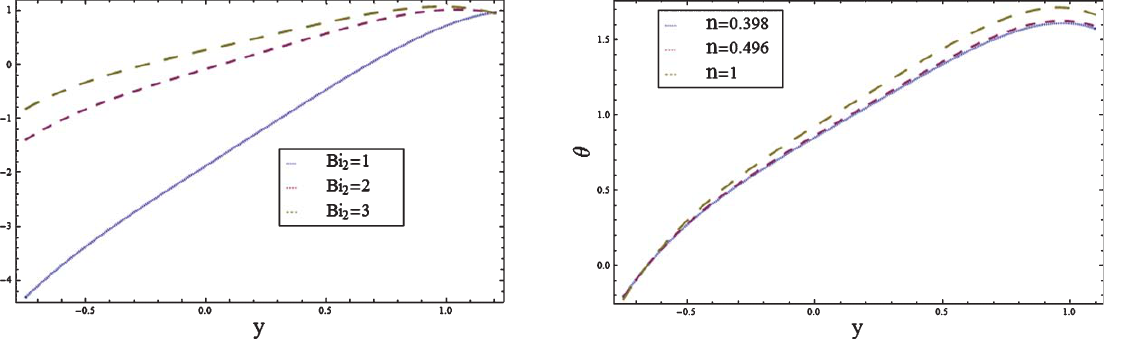
Fig.10. Plotshowing θ versus y .Here a = 0 . 3, b = 0 . 5, d = 1, φ = π/